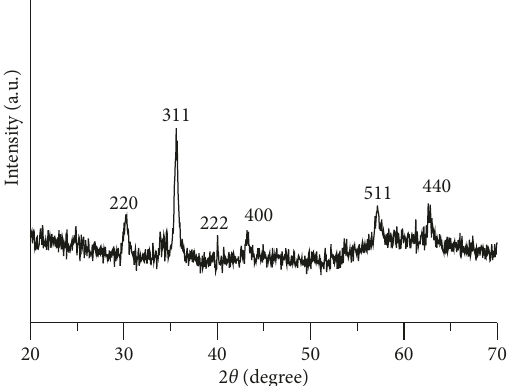
Figure 1: The XRD patterns of as-prepared Fe